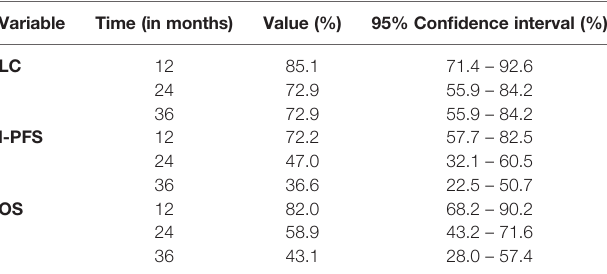
TABLE 4 | Outcome and survival data.